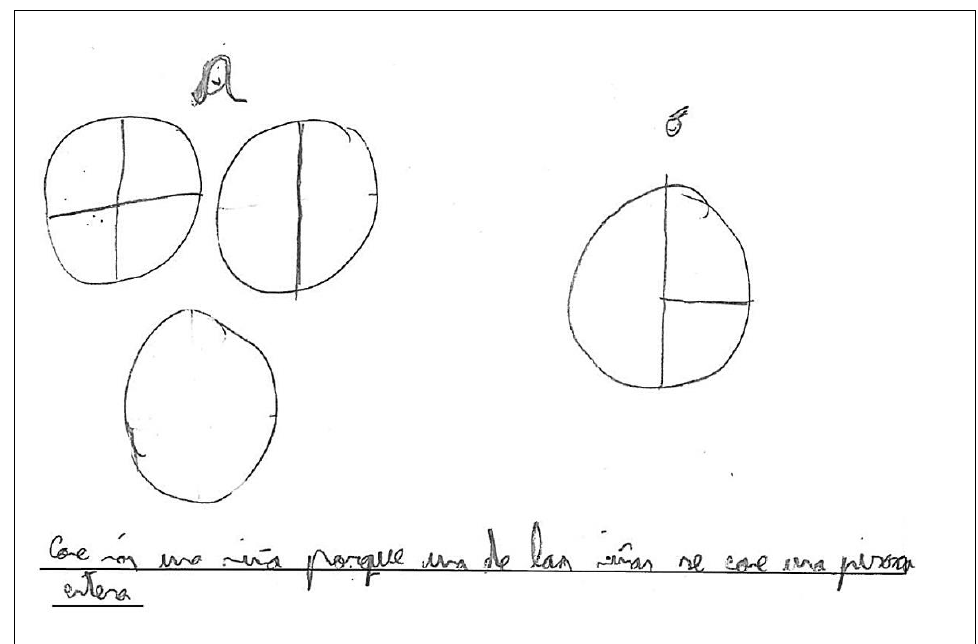
Figure 6. Uncategorised